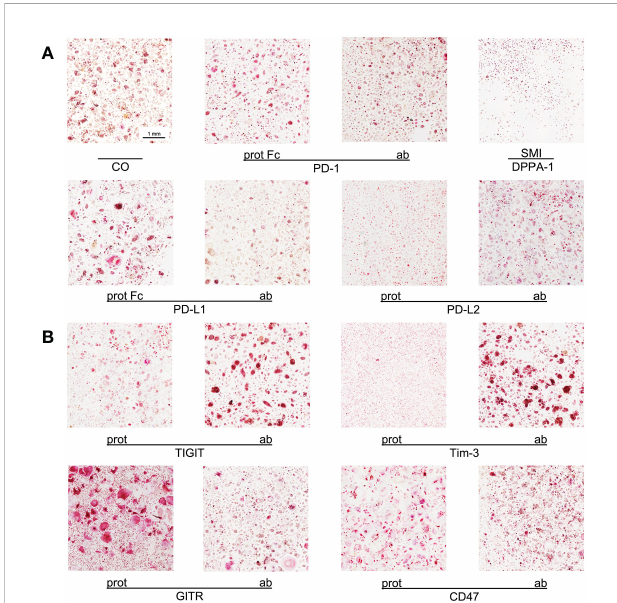
FIGURE 1 Imaging of OC differentiation under different treatment conditions. Representative images (captured at 10x magni fi cation) of OC differentiation on day 14 after induction with different checkpoint modulators. (A) Group of PD-1-related checkpoint molecules. (B) Group of checkpoint molecules that are not yet approved for clinical use. CO, control group; prot, protein; ab, antagonistic antibody; PD-1, programmed cell death protein 1; SMI, small molecule inhibitor; PD-